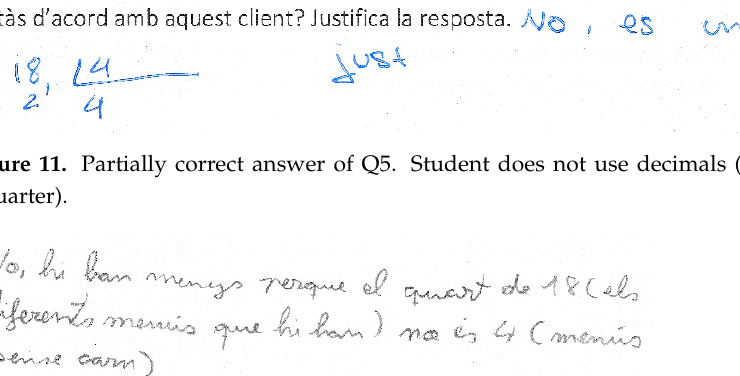
Table 9. Degree-strategy frequencies of Q5. Degree